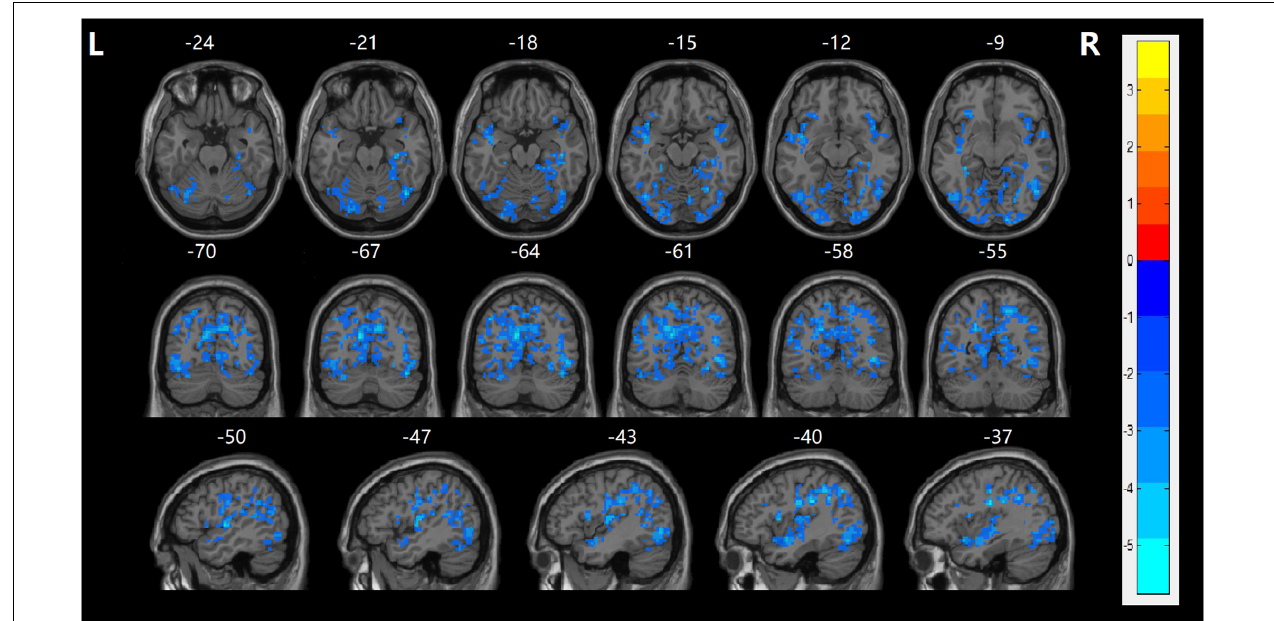
FIGURE 1 | fALFF maps show differences between the naïve patients with FES and HCs ( p < 0.05). The patients with FES showed significantly lower values in the bilateral precentral gyrus, bilateral postcentral gyrus, right lingual gyrus, bilateral temporal superior gyrus, left middle occipital gyrus, right calcarine, and left orbitofrontal cortex (LOFC) relative to both the HC group. Statistically significant differences in fALFF were defined as voxel-level, p < 0.001; cluster level, p < 0.05, TFCE corrected after correcting for age, gender, and education. T, statistical value of peak voxel showing fALFF values differences between the two groups. The cool color indicated that it decreased in the naïve patients with FES. Reversely, warm color indicated increased values in the naïve patients with FES.